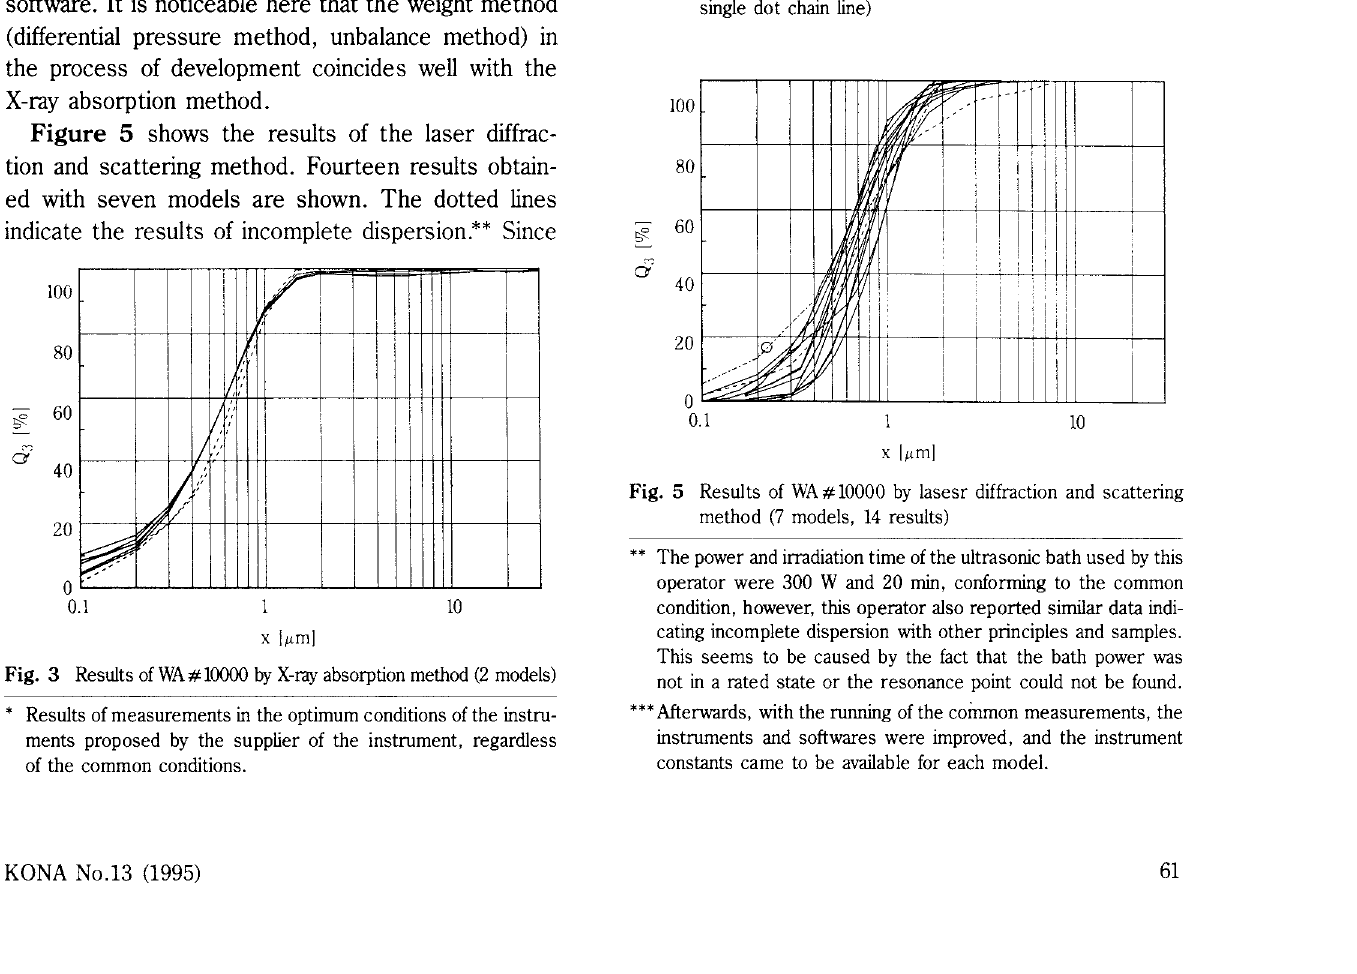
Fig. 4 Comparison of WA # 10000 on various sedimentation methods (light extinction with 3 models: solid line, X-ray method with 2 models: dotted line, weight method with 2 models: single dot chain line)